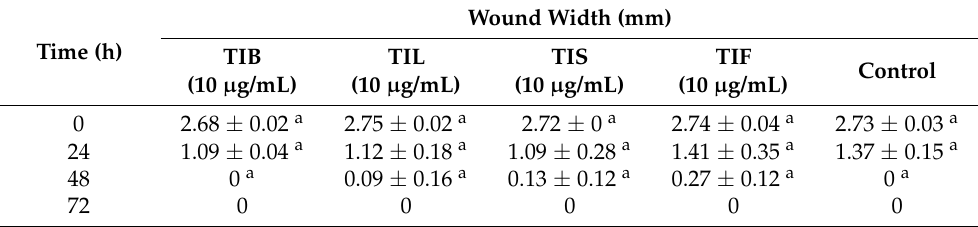
Means bearing same script ( a ) are not significantly different from control at p < 0.05, Mean ± Standard error.